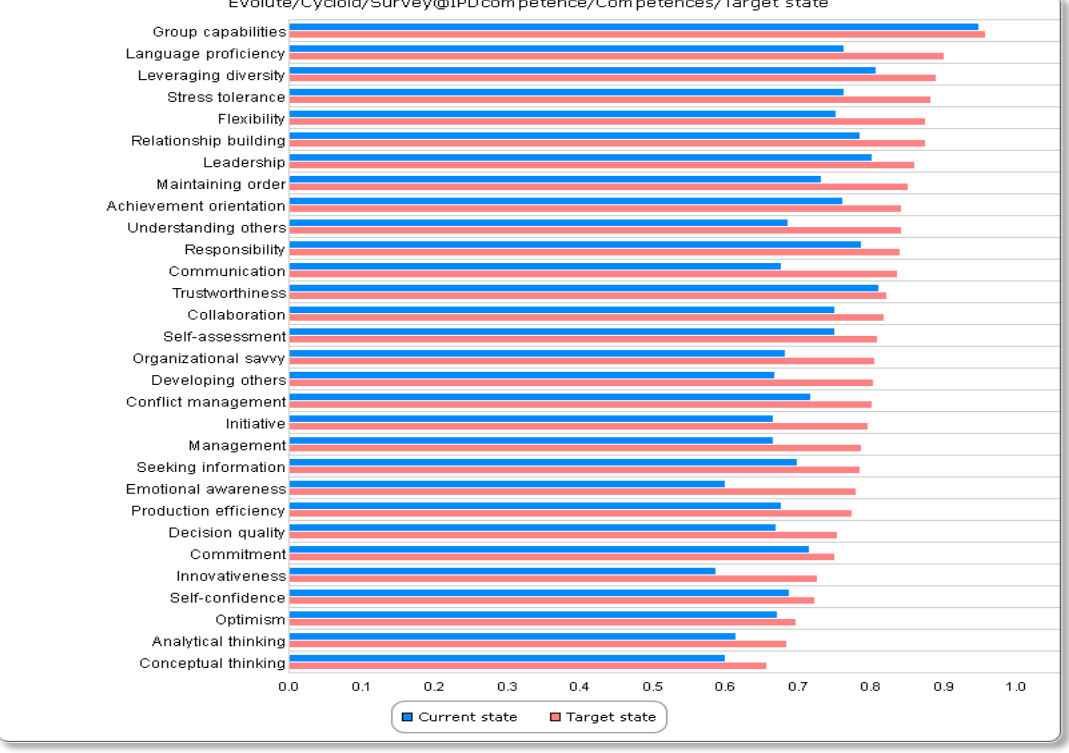
Figure 5. Project managers’ competencies sorted according to their significance in the target state.